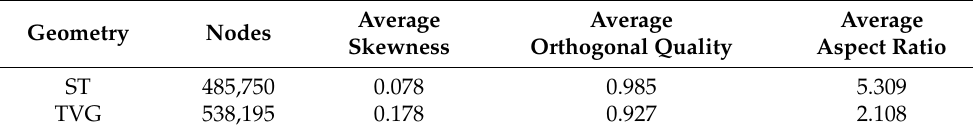
( b ) Figure 4. Grid independency verification; ( a ) grid independency verification of Nu ; ( b ) grid inde- pendency verification of f .